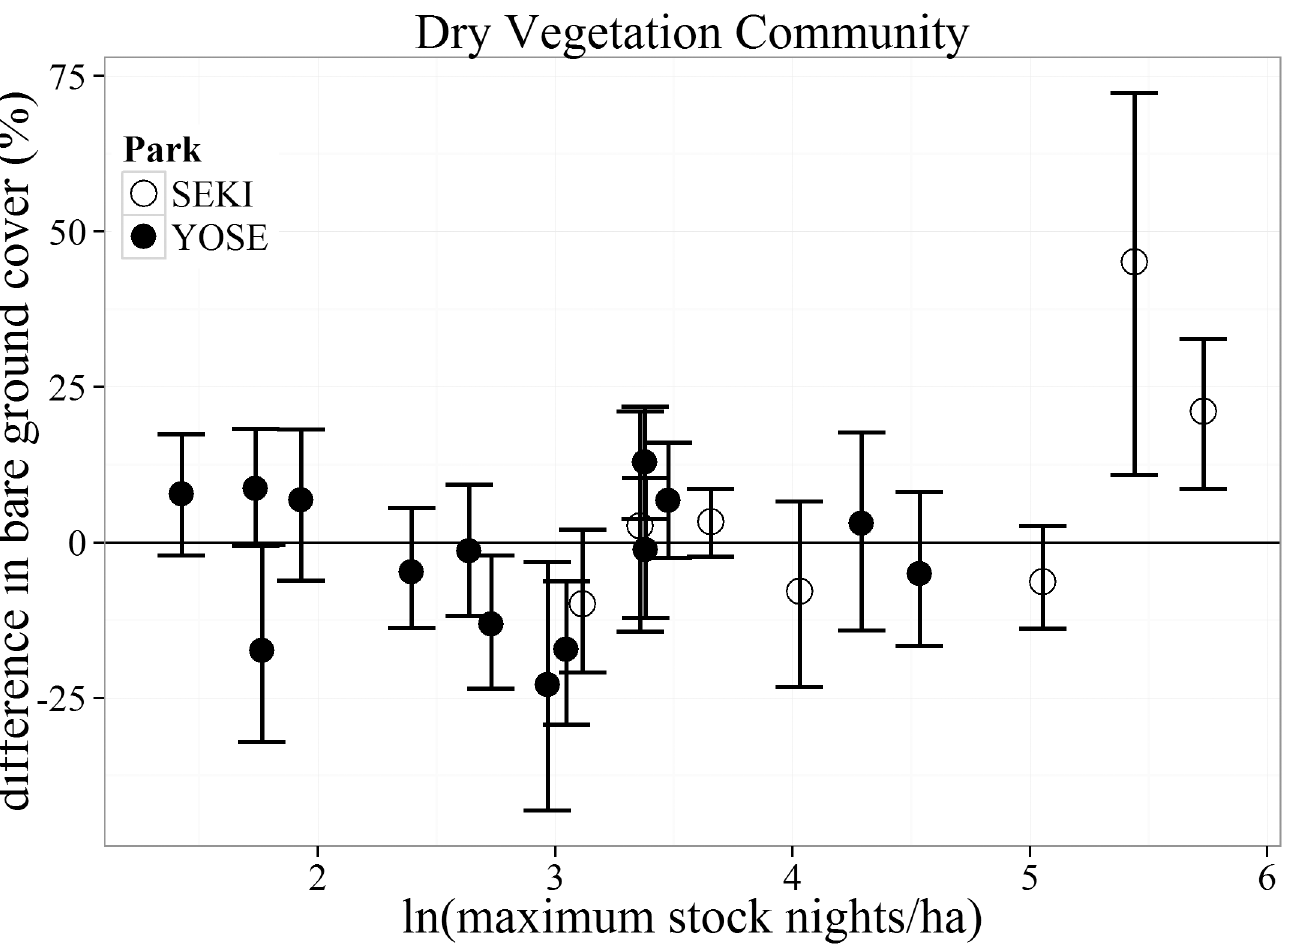
Fig 4. Bootstrapped mean (with 95% confidence intervals) differences in percent bare ground cover for the Dry vegetation communities between matched meadows (N = 22) in Yosemite (YOSE) and Sequoia (SEKI) National Parks. The range of 1–5.7 (ln) maximum stock nights/ha corresponds to a range of 4–308 untransformed maximum stock